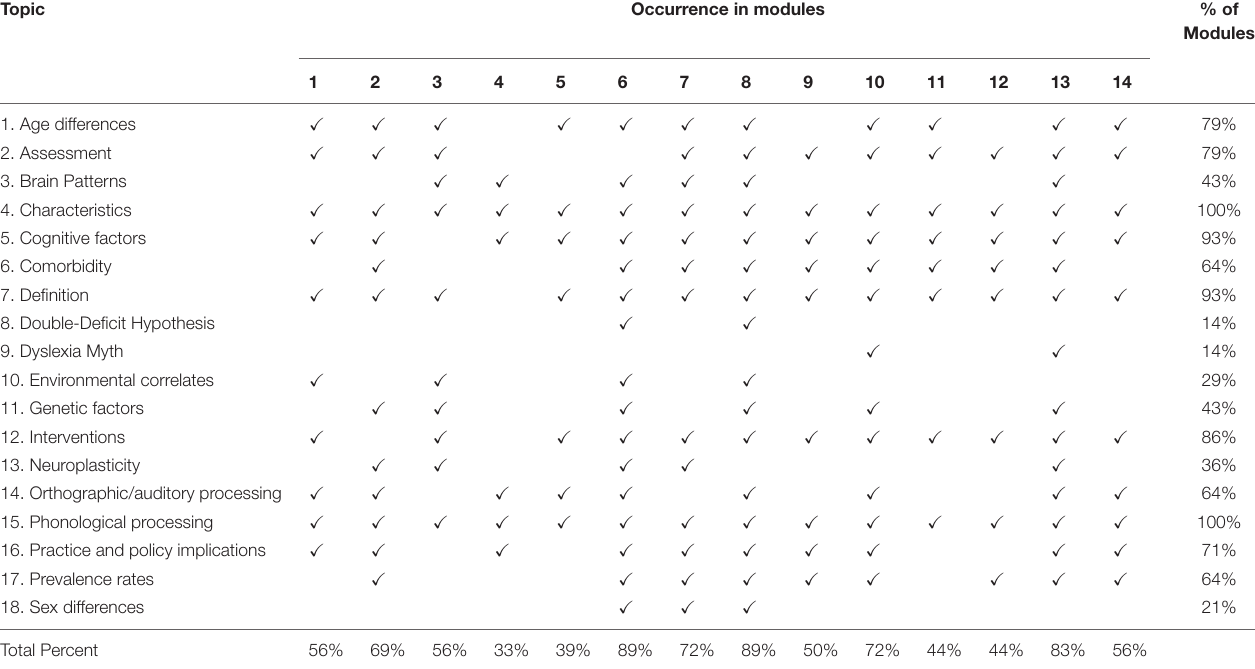
TABLE 3 | Frequency of topics’ occurrence within and across dyslexia